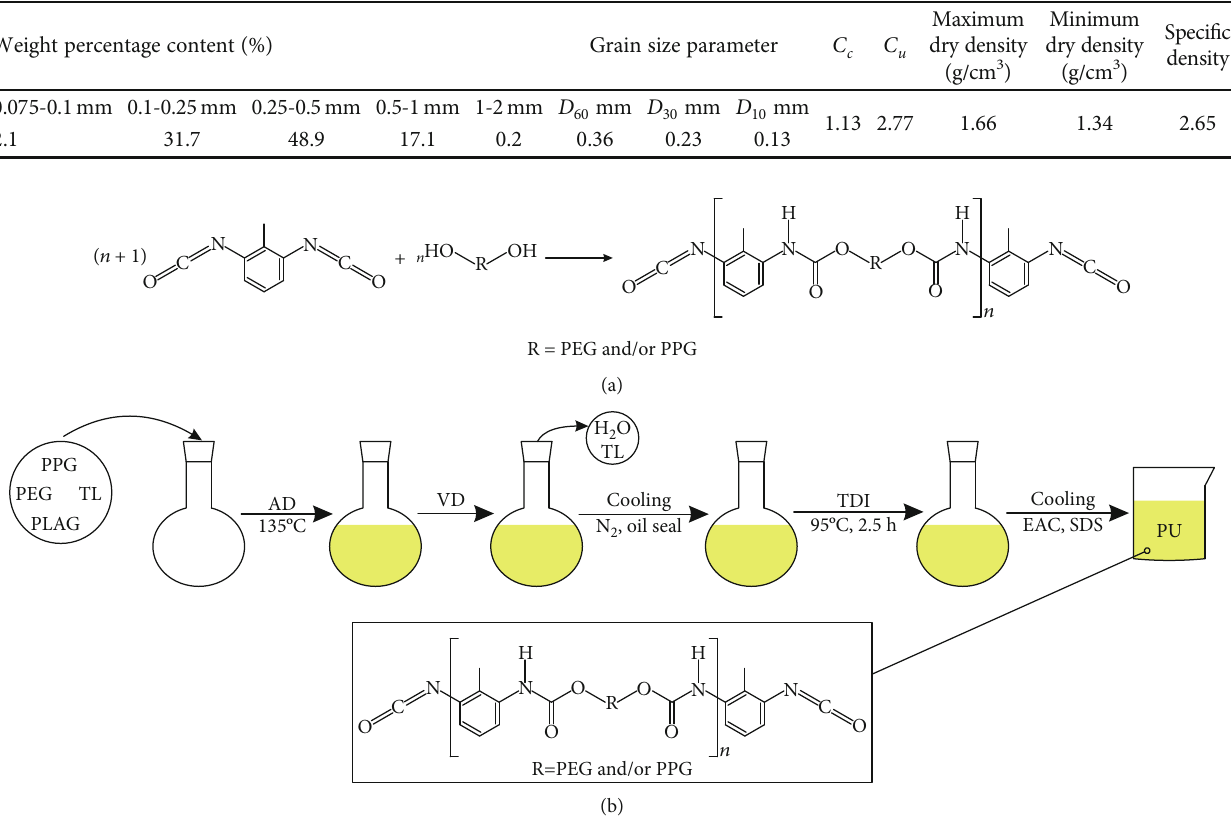
Figure 1: (a) The constitutional formula of polyurethane; (b) the corresponding synthetization diagram. Table 2: The detailed parameters of the